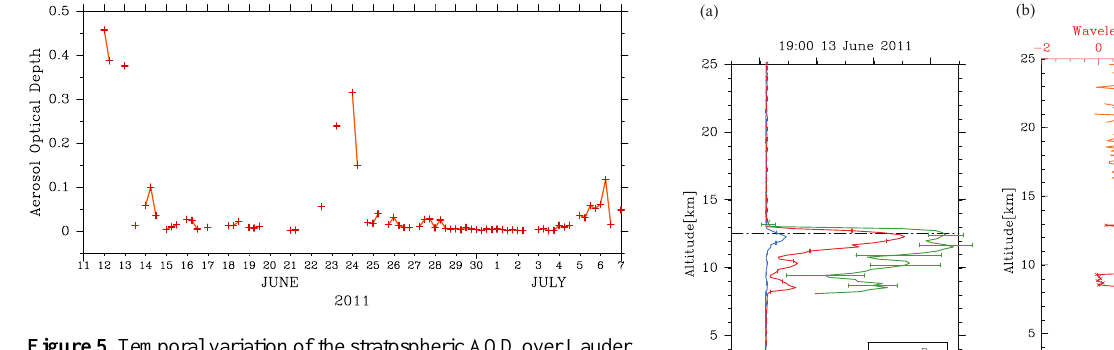
Fig.5 Figure 5. Temporal variation of the stratospheric AOD over Lauder from 11 June to 6 July 2011. Three AOD peaks occurred of 0.45 on 11 June, 0.31 on 23 June and 0.12 on 6 July.